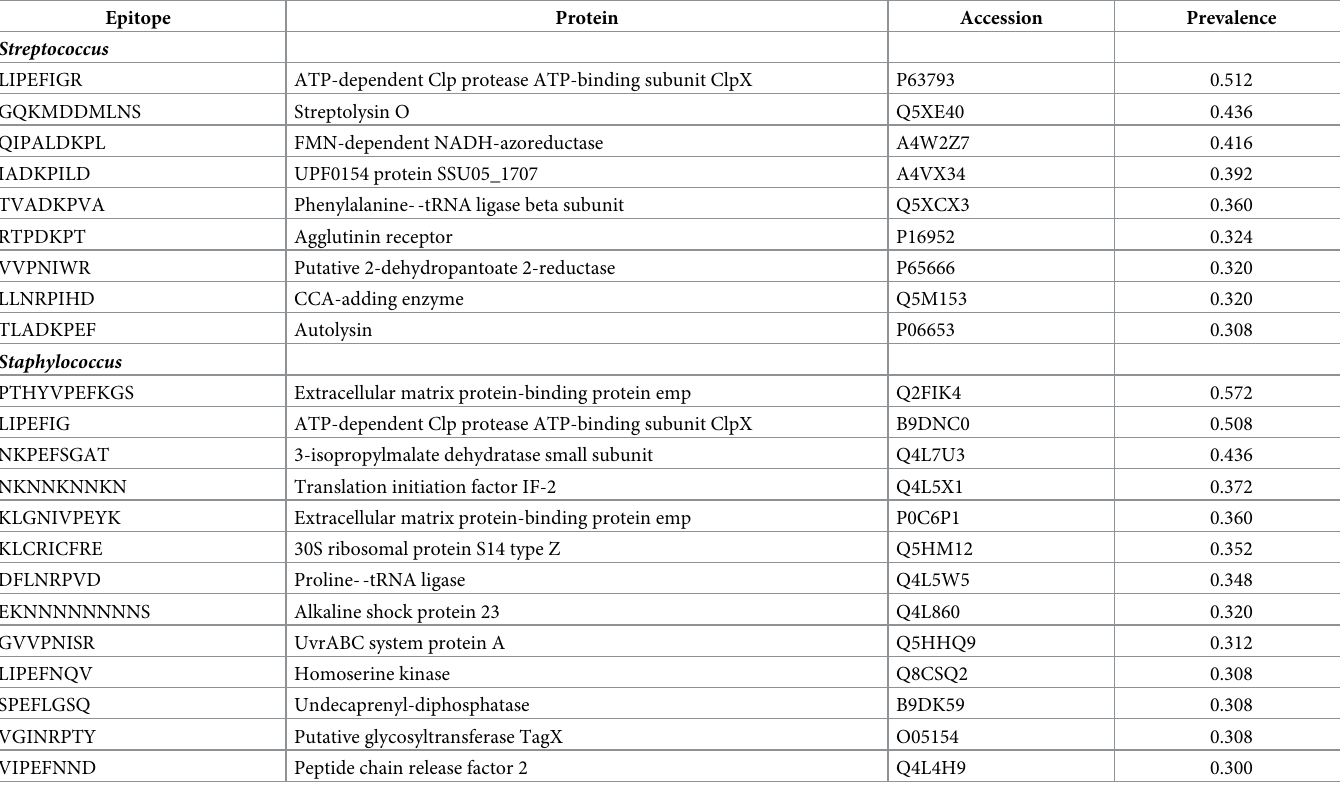
Table 2. Epitopes in the proteomes of the genera Staphylococcus and Streptococcus which were bound by > 30% of 250